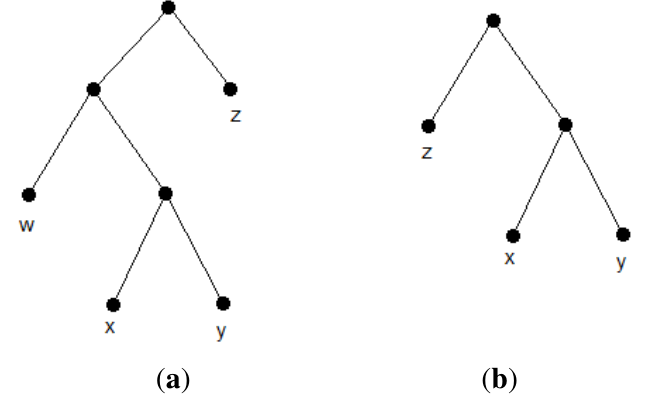
Figure 1. Example of a phylogenetic tree and a consistent triplet. ( a ) A phylogenetic tree; ( b ) the triplet xy | z